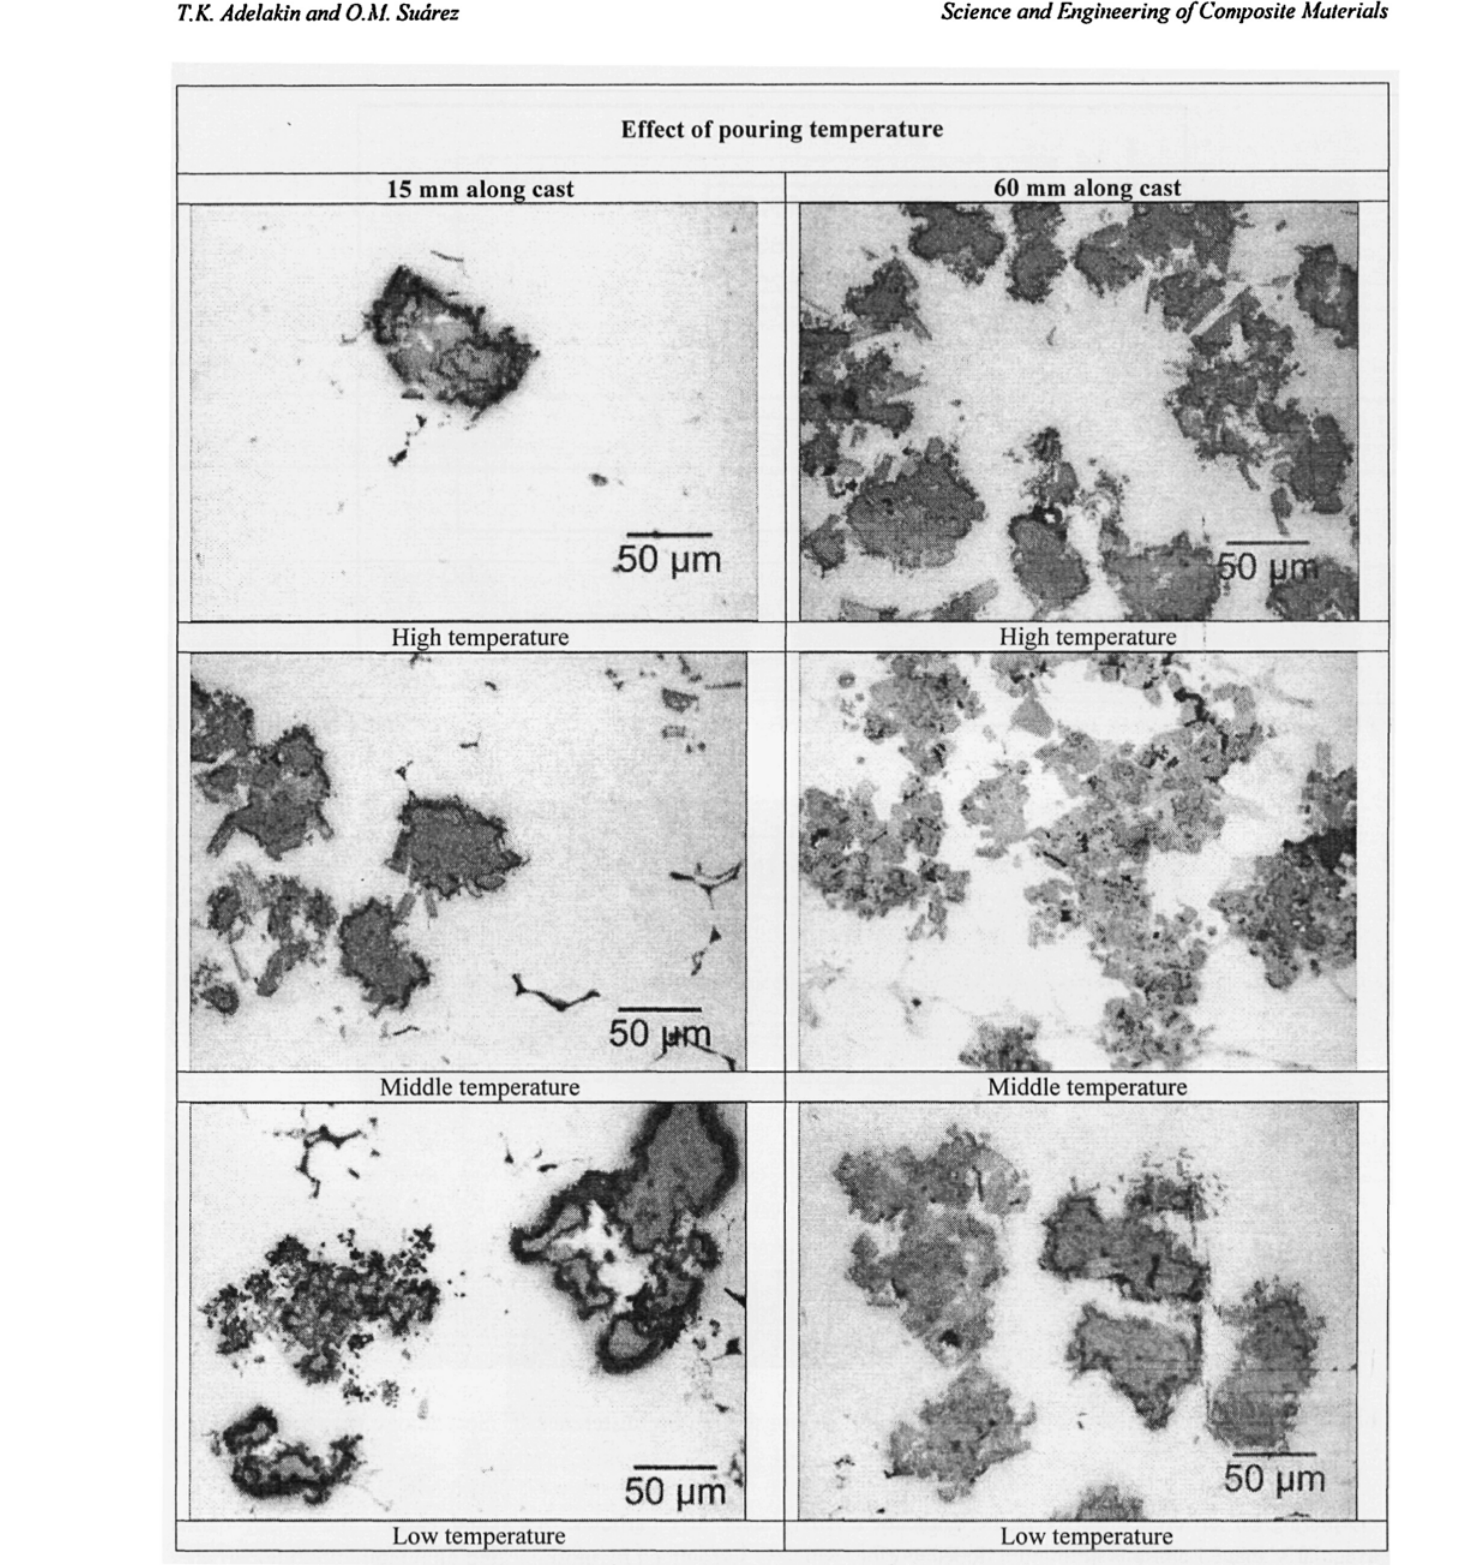
Fig. 7: Photomicrographs of as-cast microstructures of Al-B-Mg composites along the main axis of the cylindrical castings showing the effect of pouring